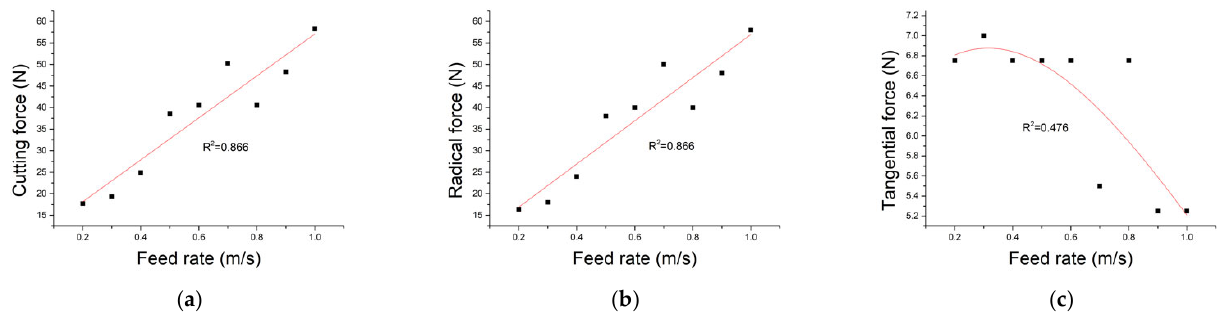
Figure 4. ( a ) Effect of feed rate on cutting force; ( b ) effect of feed rate on radical force; ( c ) effect of feed rate on tangential force.